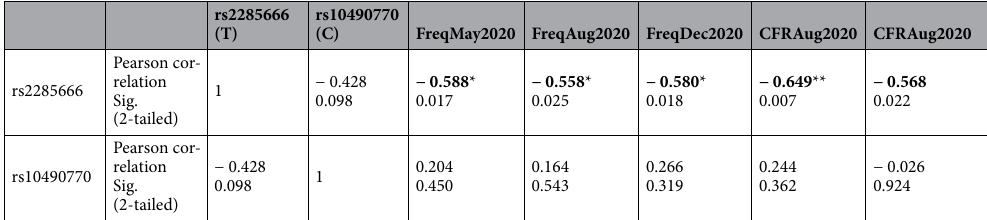
Table 1. Estimates of Pearson correlation coefficient for the rs2285666 and rs10490770 with the real-time COVID-19 cases as well as case fatality rate among Indian populations. The significant values are shown in bold letters. *Correlation is significant at the 0.05 level (2-tailed). **Correlation is significant at the 0.01 level